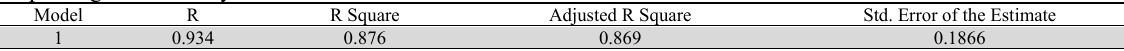
Table ٣ Multiple Regression Analysis of SA Factors with CA Model